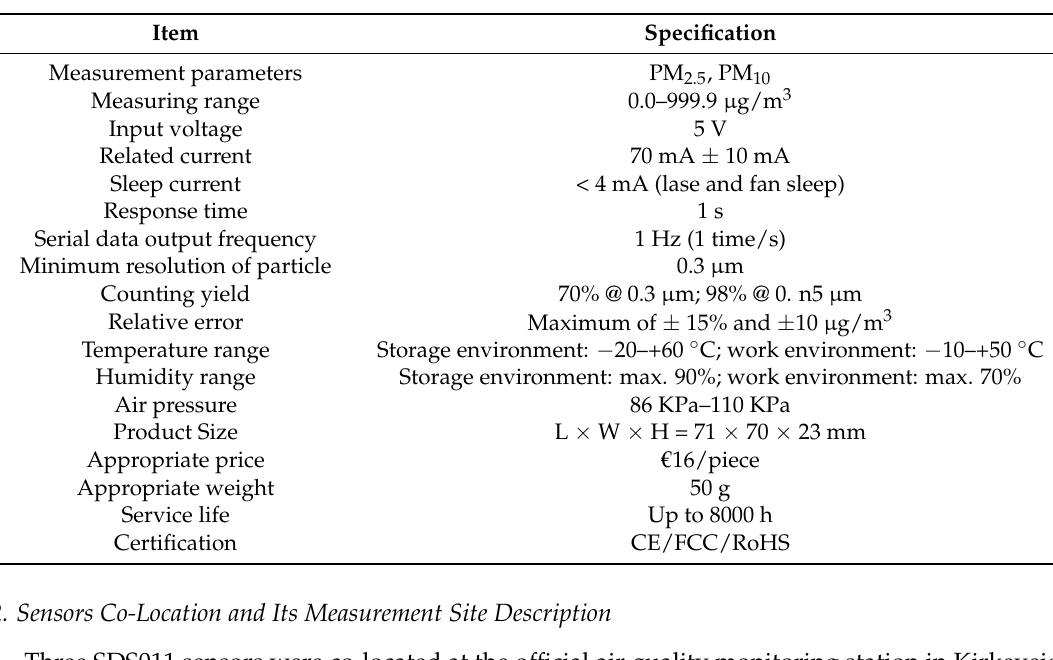
Table 1. Characteristics of the Nova PM sensor SDS011 [17].